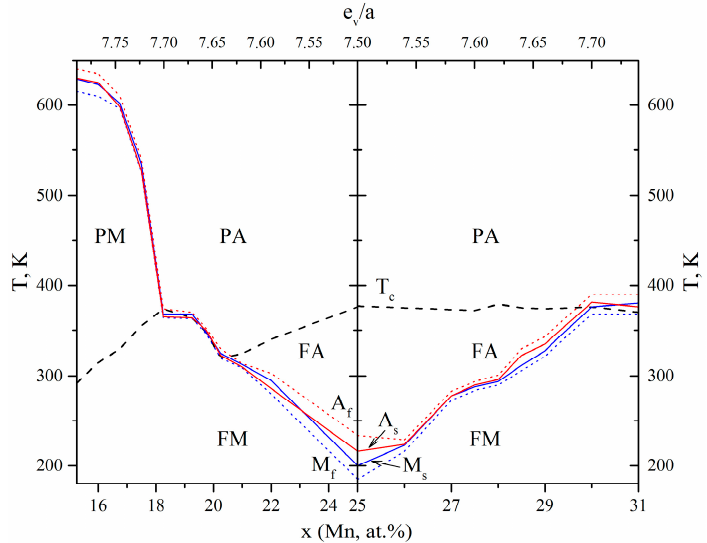
Figure 5. The temperature-concentration diagram of magnetic and martensitic transformations of Ni 50+x Mn x Ga 25 (left of x = 25) and Ni 50 Mn x Ga 50 − x -based alloys (right). The phase fields of paramagnetic (P) and ferromagnetic (F) austenite (A) and martensite (M) are indicated. Table 5. Chemical composition, temperatures of TMTs B2 ↔ B19 ′ , the number of valence electrons per atom e v /a and their concentration c v .